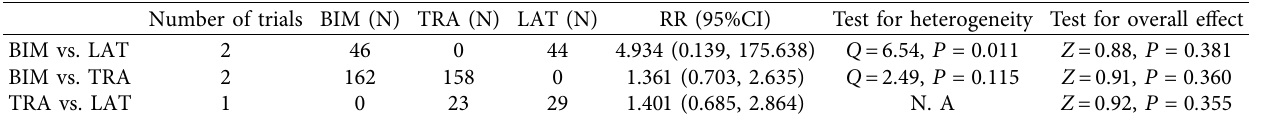
Table 6: Responsiveness of PGAs in